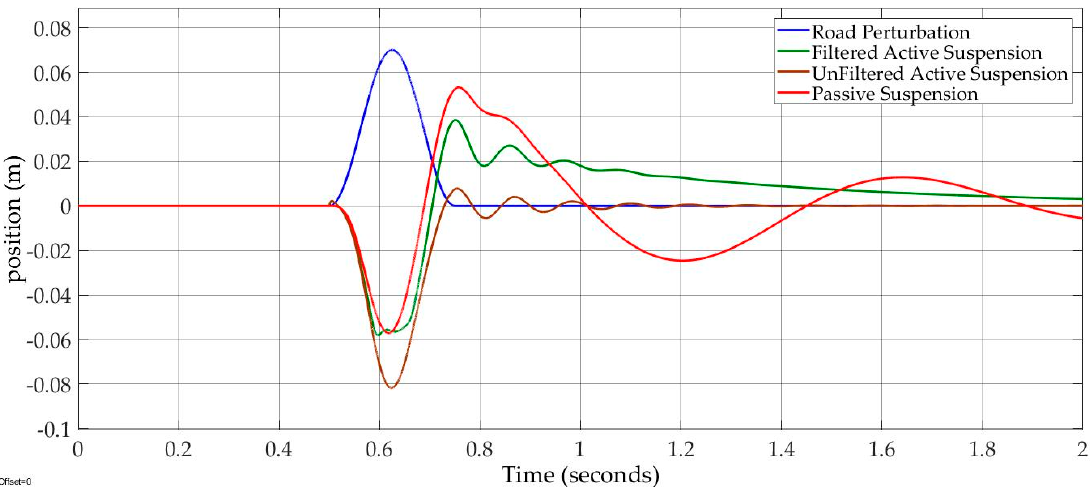
Figure 15. Suspension travel of Case 3.